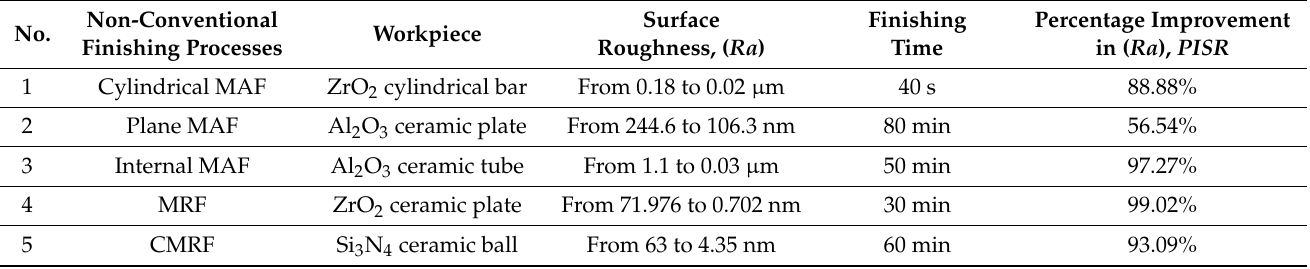
Table 2. Surface finish of advanced ceramics obtainable by non-conventional finishing